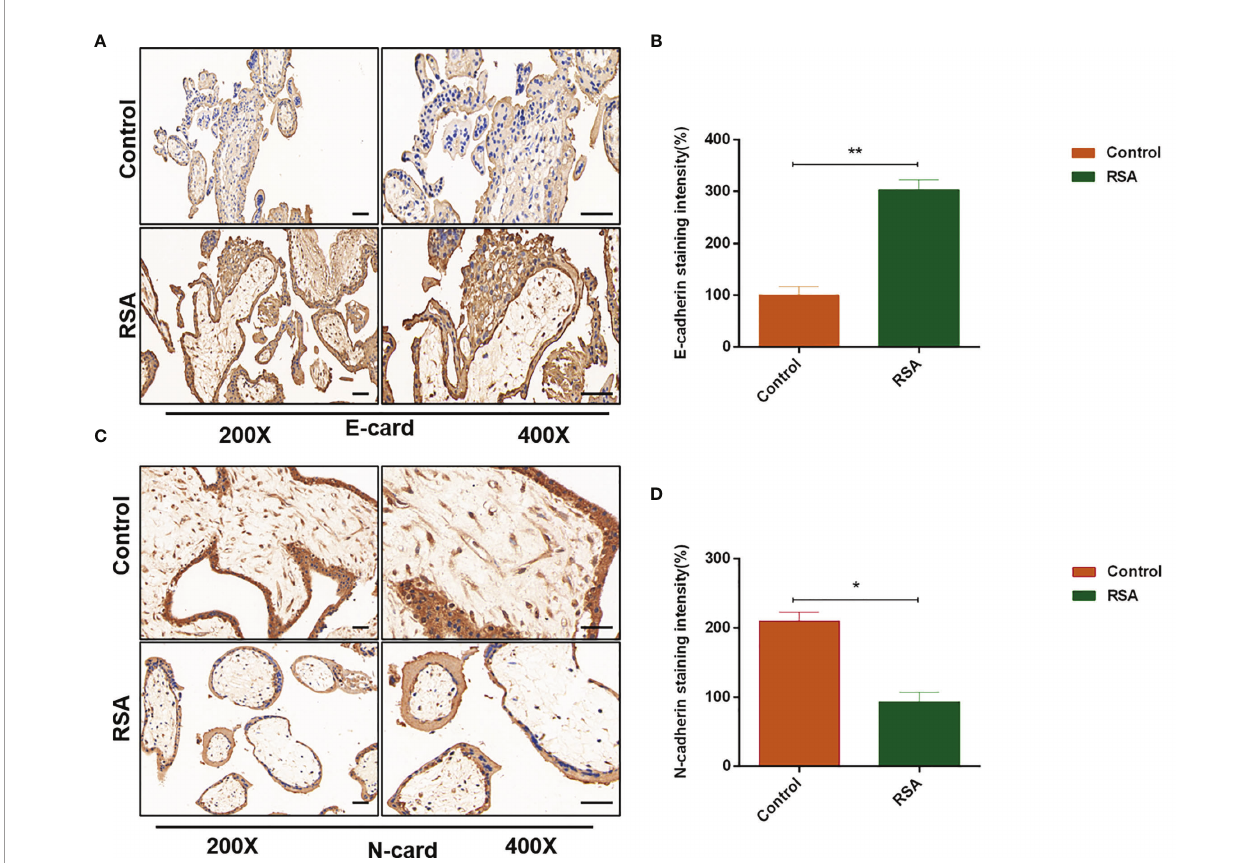
FIGURE 5 | Expression of E-cadherin and N-cadherin in human placental villous tissues from the RSA group and the control group. Placental villous tissues from women with RSA (n = 15) and normal controls (n = 13) were used for the IHC assay. (A, B) Representative immunohistochemical staining images and quanti fi cation of E-cadherin in the RSA group (n = 15) and normal group (n = 13). (C, D) Representative immunohistochemical staining images and quanti fi cation of N-cadherin in the RSA group (n = 15) and normal group (n = 13). The staining intensity is quanti fi ed using ImageJ. Magni fi cation, ×200 and ×400. Scale bars = 100 m m. Graphs show the mean ± SD. Results are reported as fold change compared with the control group (* p < 0.05, ** p < 0.01). RSA, recurrent spontaneous abortion; IHC,